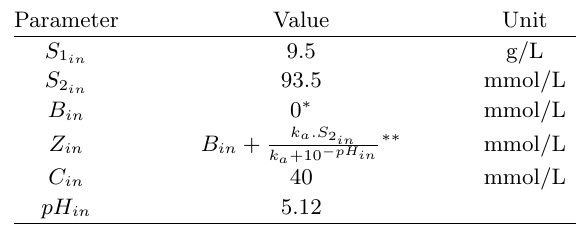
Table 3: The feed sludge characterization